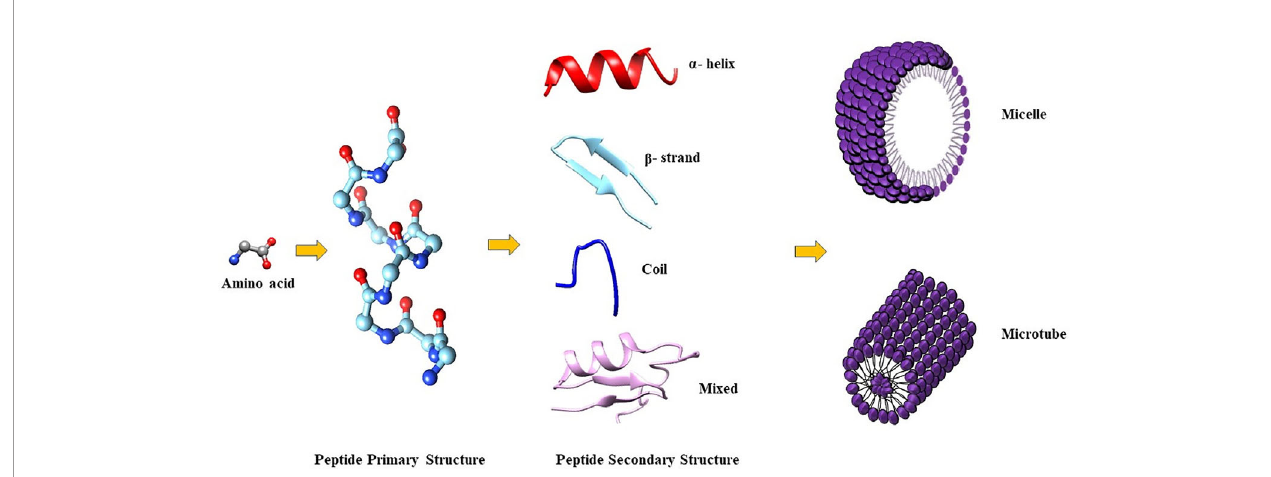
FIGURE 5 | Arrangement of peptide amphiphiles in self-assembling nanostructures (e.g., micelles and microtubes), which can contain and release APIs. Adapted from Song et al. (2017). Figure created with UCSF CHIMERA software (Pettersen et al.,